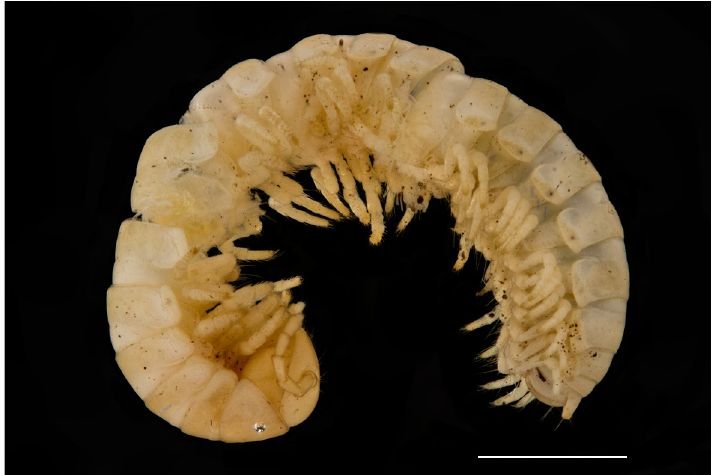
Fig. 20. Agrophogonus pusillokiellandi Olsen & Enghoff sp. nov., holotype, ♂ (NHMD 621683). Scale bar: 5